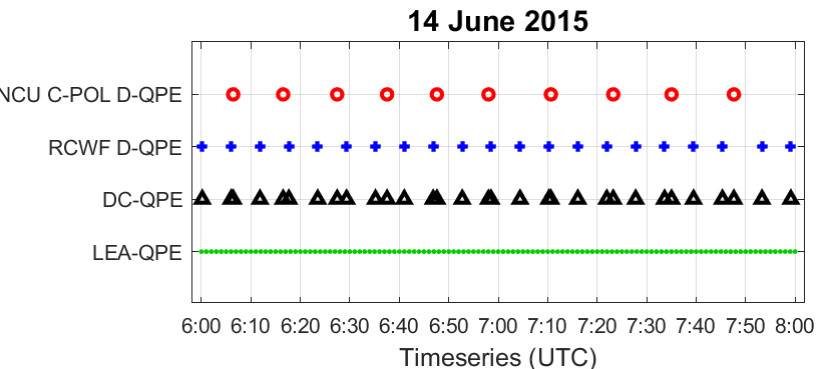
Figure 5. An example of time steps of available data for QPE on 14 June, 2015. Red circles represent the NCU C-POL discrete QPE (NCU C-POL D-QPE), and blue crosses for the RCWF discrete QPE (RCWF D-QPE). Black triangles are the discretely combined C- and S-band QPE (DC-QPE) and green dots are the Lagrangian-evolution adjustment QPE (LEA-QPE).